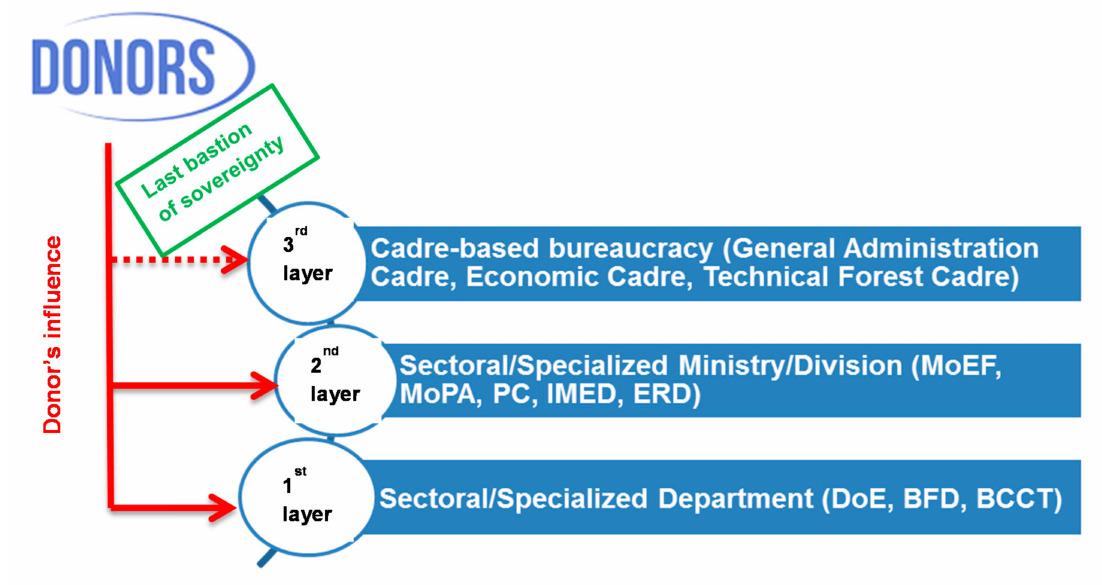
Figure 6. Layering of state administration related to climate change and foreign donor’s